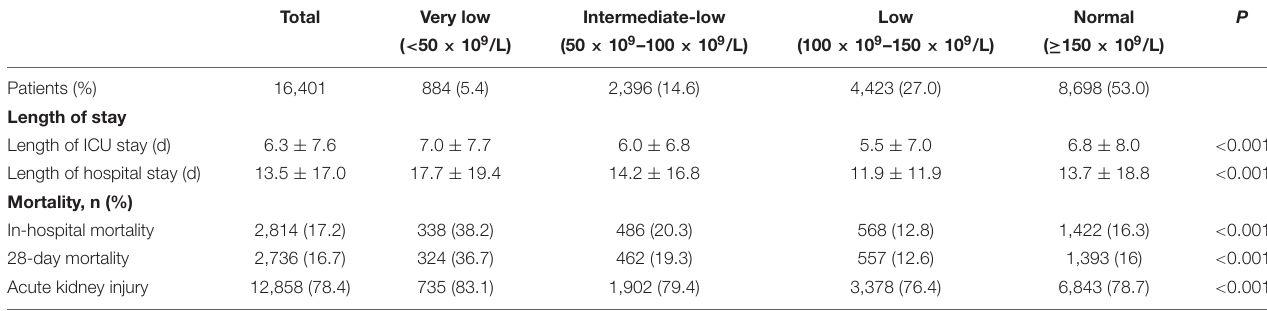
TABLE 2 | Outcome of sepsis patients stratified according to platelet counts.